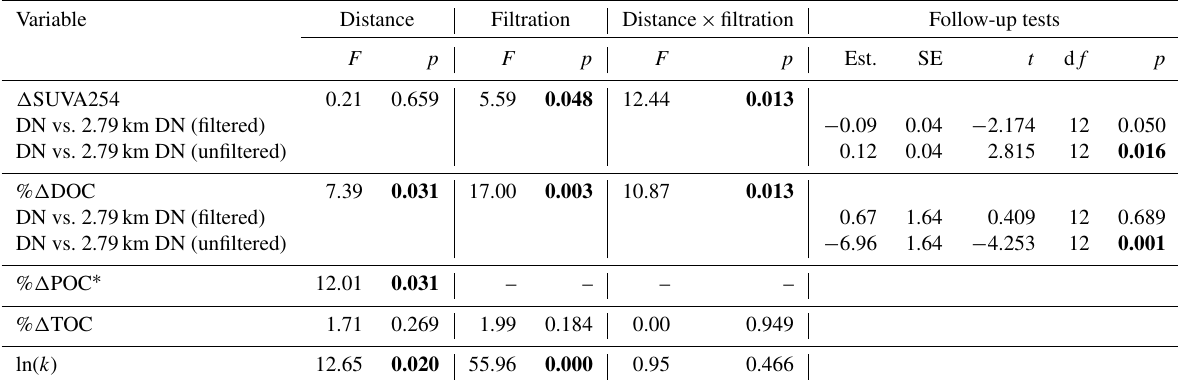
Table A3. Two-way ANOVAs for transect experiment examining effects of filtrations (unfiltered vs. filtered) and distance (immediately downstream vs. 2.79km downstream) from slump SE and interactions between the two. Since multiple (four to five) parameters from the same experiment are tested, p values (in bold if less than 0.050) were corrected for false discovery rate. Degrees of freedom associated with distance, filtration, interaction, and residuals are 1, 1, 1, and 12 respectively for all tests, except % (cid:49) POC for which degrees of freedom for distance and residuals are 1 and 14